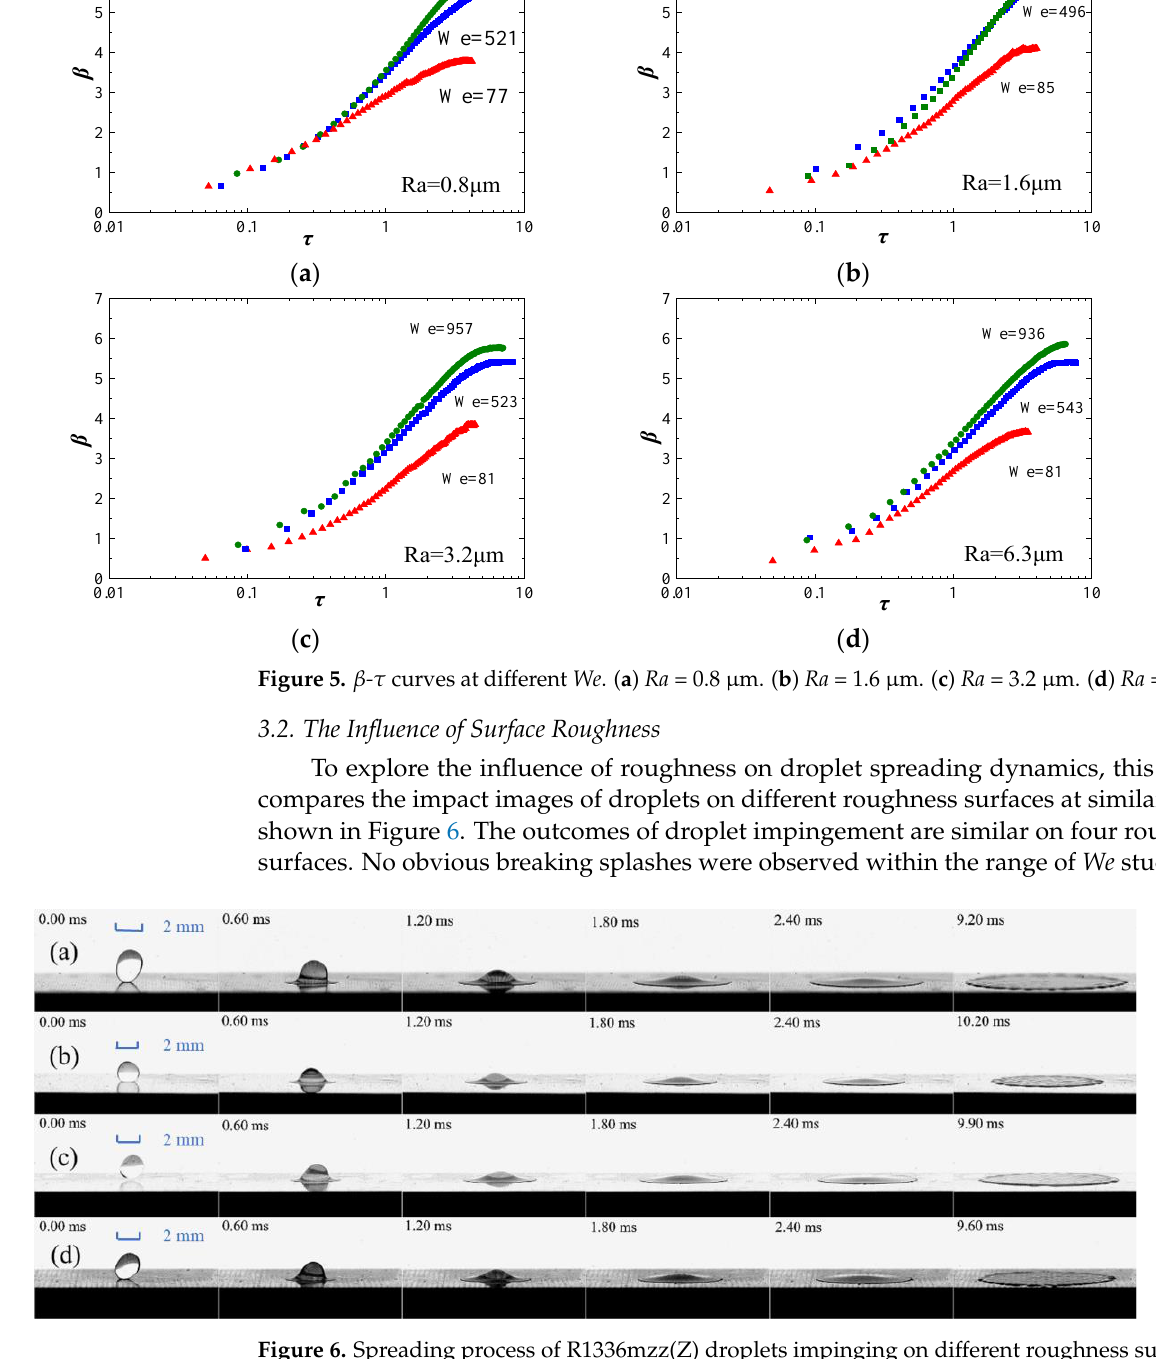
Figure 6. Spreading process of R1336mzz(Z) droplets impinging on different roughness surfaces at medium We ( We ≈ 520) . ( a ) Ra = 0.8 μm, ( b ) Ra = 1.6 μm, ( c ) Ra = 3.2 μm and ( d ) Ra = 6.3 μm.